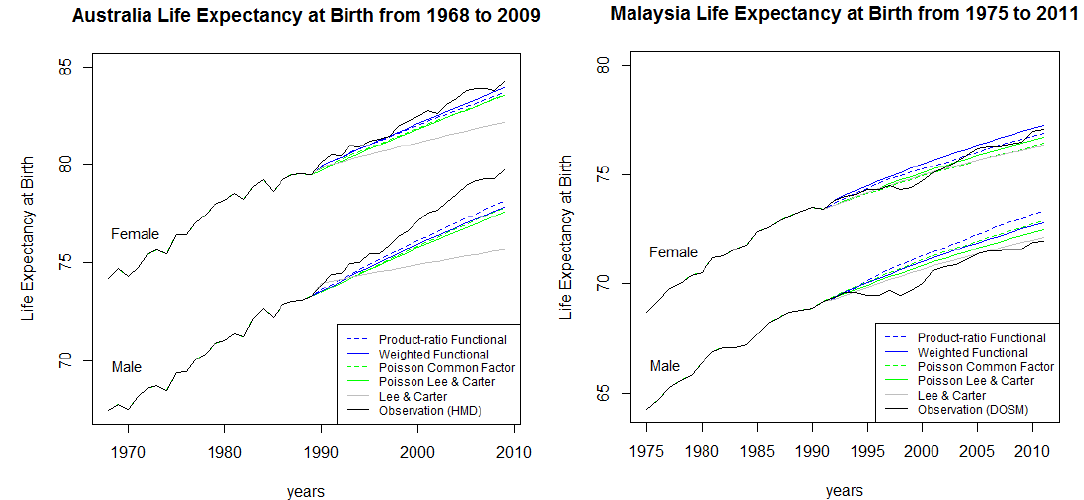
Figure 6. Observed and 20-year forecasts of Australian ( left ) and Malaysian ( right ) life expectancies at birth for males and females.